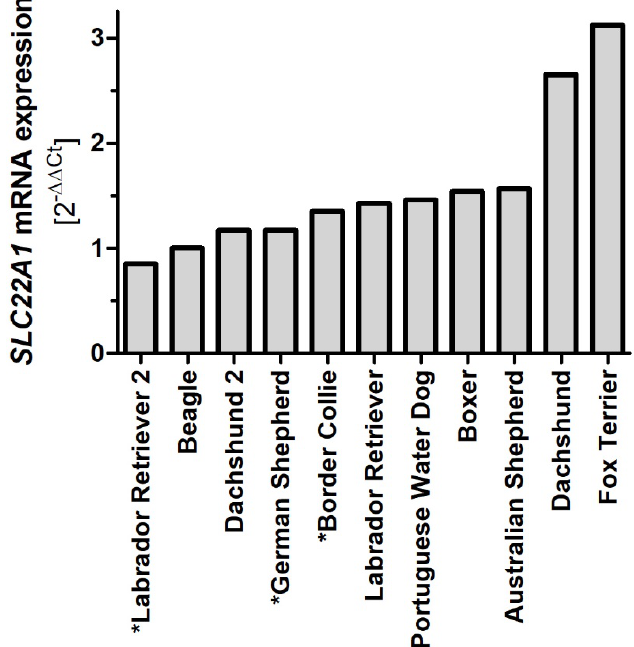
Figure 8. Comparison of OCT1 mRNA expression in liver samples from different dogs. Expression of OCT1 ( SLC22A1 ) was measured in cDNA from eleven liver samples originating from eight different breeds using RT-qPCR. Expression was normalized to the expression of TBP and Beagle was used as reference. * Denotes samples that were not cloned and sequenced.